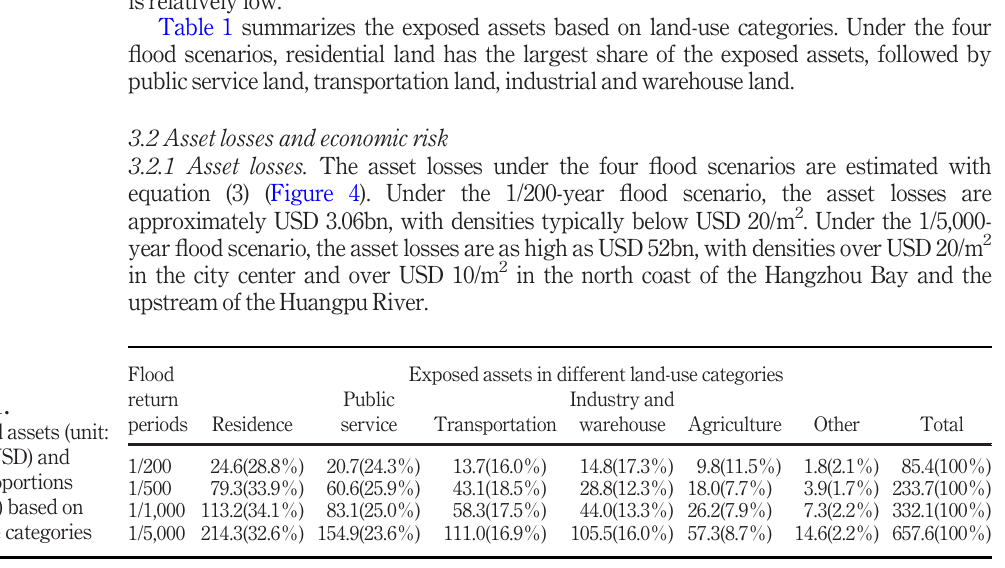
Table 1. Exposed assets (unit: billion USD) and their proportions (unit: %) based on land-use categories